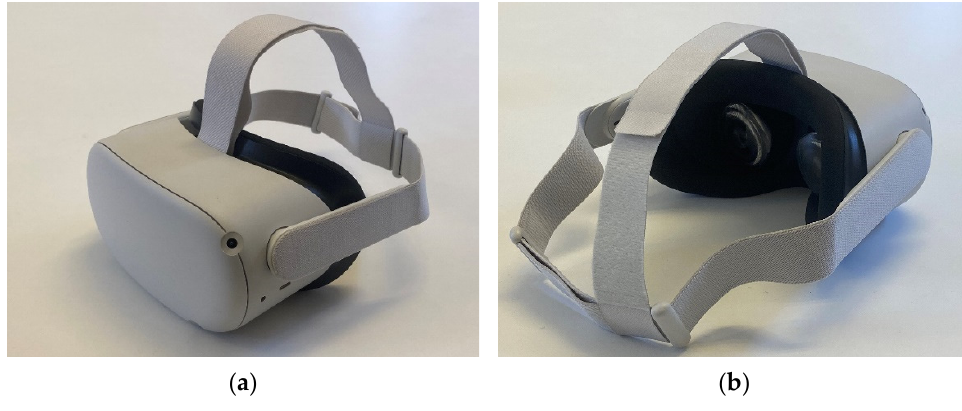
Figure 2. Meta Quest 2 VR headset. ( a ) Front view; ( b ) Rear view. Table 6. Main VR tethered and standalone headsets on the